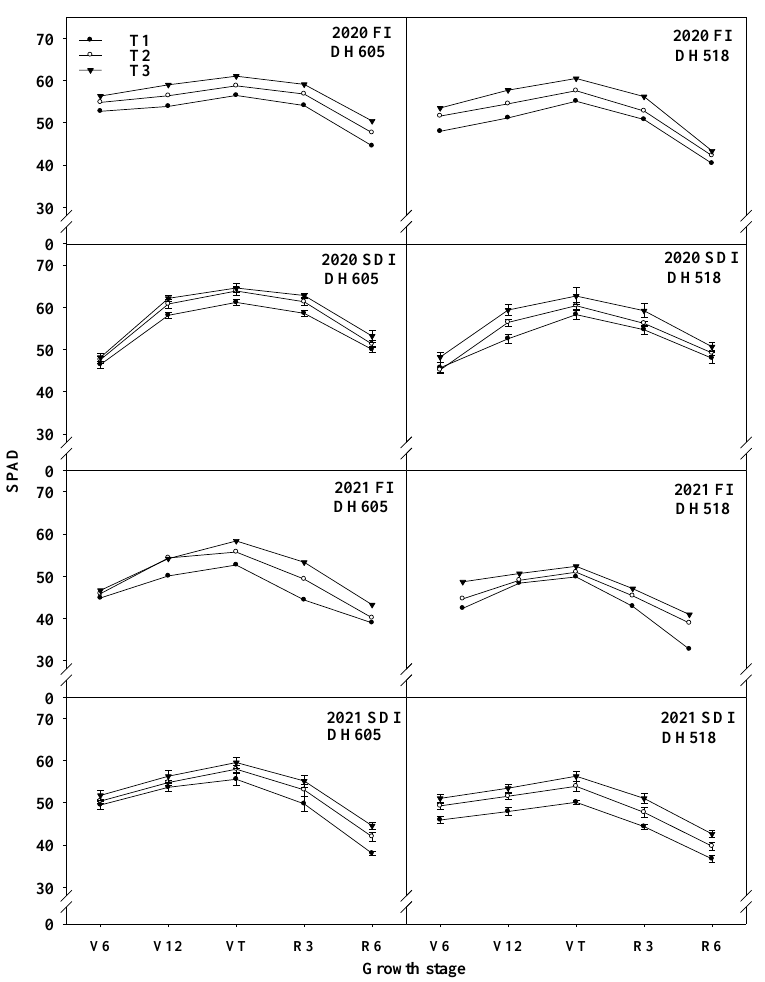
Figure 2. SPAD value of two corn hybrids differing in maturity under different irrigation treat- ments.